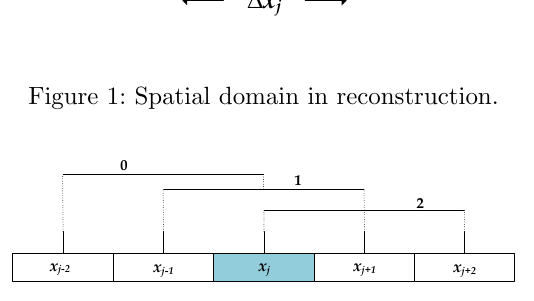
Figure 2: Five stencils for WENO